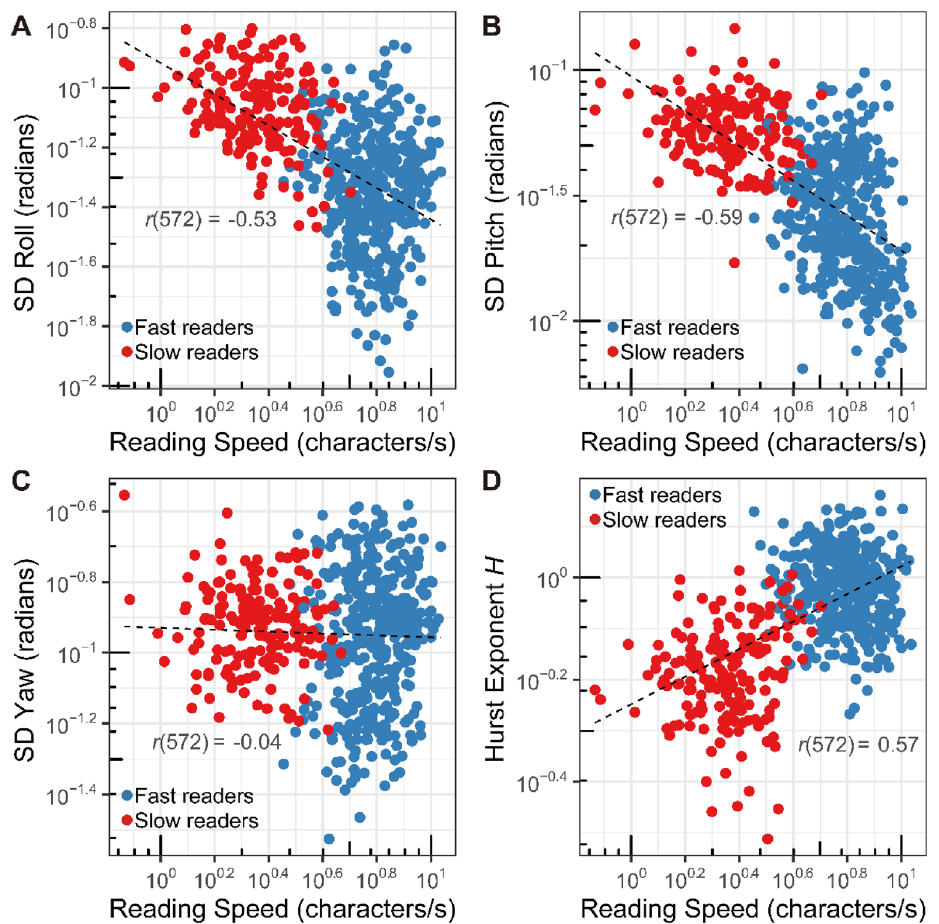
Figure 5. ( A ) The relation between mean angular standard deviations of roll angle of the reading finger and reading speed ( r 2 = 0.30, p < 0.0001), ( B ) between mean angular standard deviations of pitch of the reading finger and reading speed ( r 2 = 0.38, p < 0.0001), ( C ) between mean angular standard deviations of yaw of the reading finger and reading speed ( r 2 = 0.00 p = 0.39), and ( D ) between Hurst exponent H of scanning movement time series and reading speed for each line ( r 2 = 0.32, p < 0.0001), colored according to the group (fast readers and slow readers). Recordings over multiple recording sessions and repetitions are pooled. Each variable is computed for each line of the braille passage. Figure prepared in R software (version 4.0.2, R Core Team, 2020, Vienna, Austria) 43 .